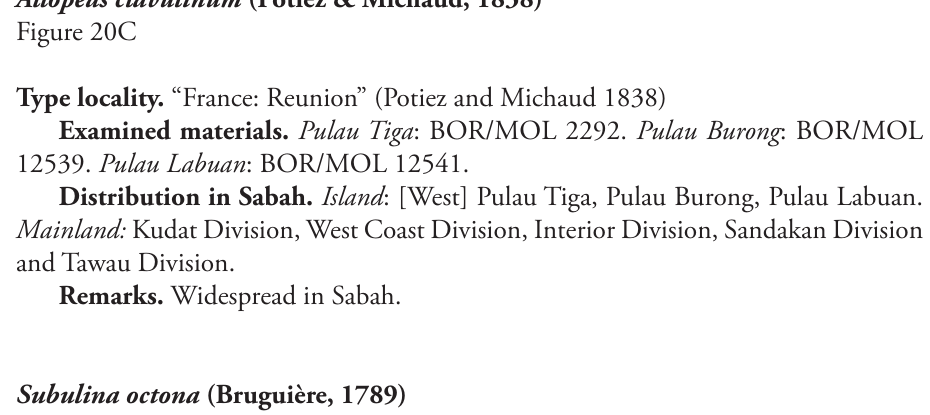
Type locality. “France: Antilles, Guadelupe, Dominican Republic” (Bruguière 1789) Examined materials. Pulau Udar Kecil : BOR/MOL 7157, BOR/MOL 7158, BOR/MOL 10378, BOR/MOL 10384. Pulau Manukan : BOR/MOL 6748, BOR/ MOL 6757, BOR/MOL 6758, BOR/MOL 10300, BOR/MOL 10305, BOR/MOL 10308, BOR/MOL 10320, BOR/MOL 6759, BOR/MOL 10325. Pulau